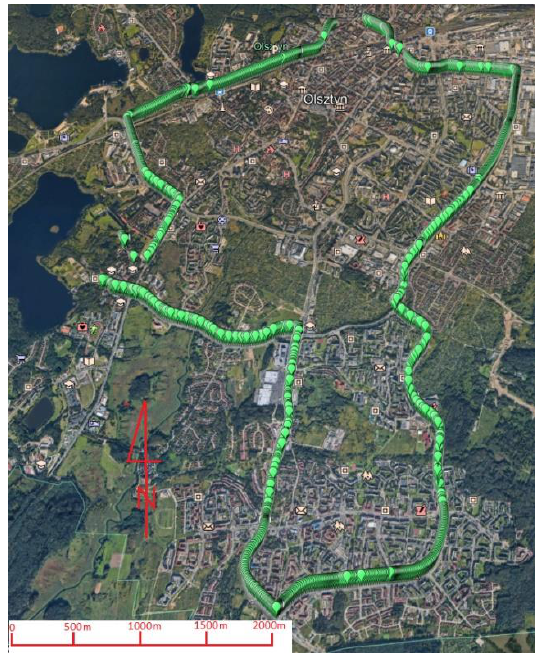
Figure 2. Google Earth view of the car test route (Olsztyn, Poland).